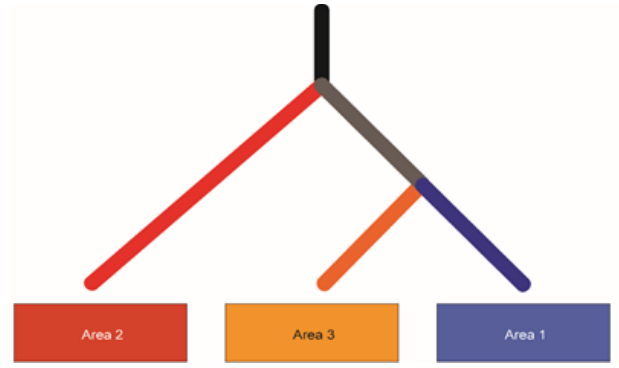
Figure 7. Phylogenetic Tree. A predicted phylogenetic tree of the tumor subclones.